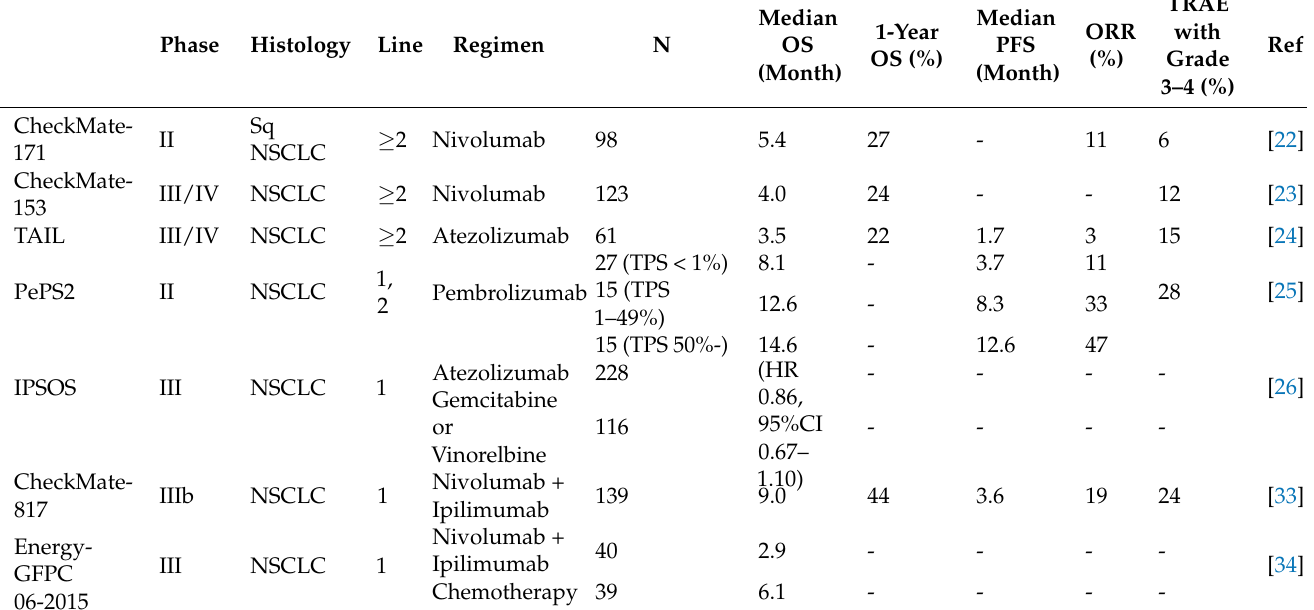
Table 2. Key prospective studies of ICI for NSCLC with PS